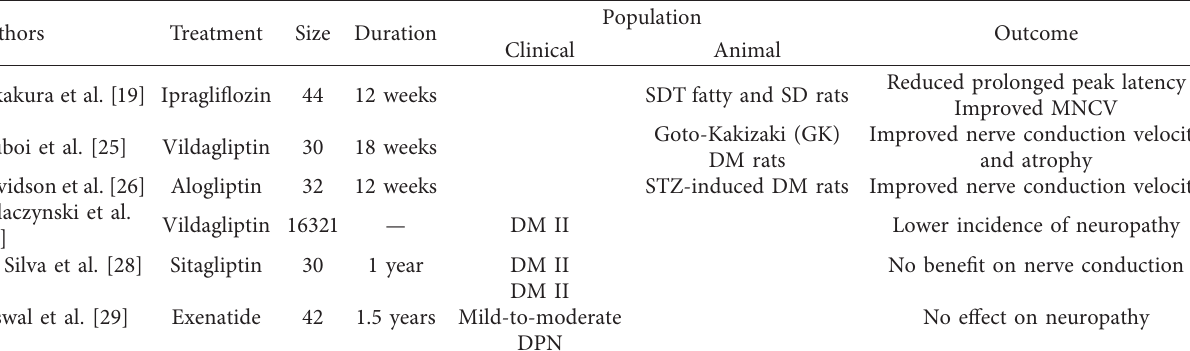
Table 2: Overview of the neurological protective